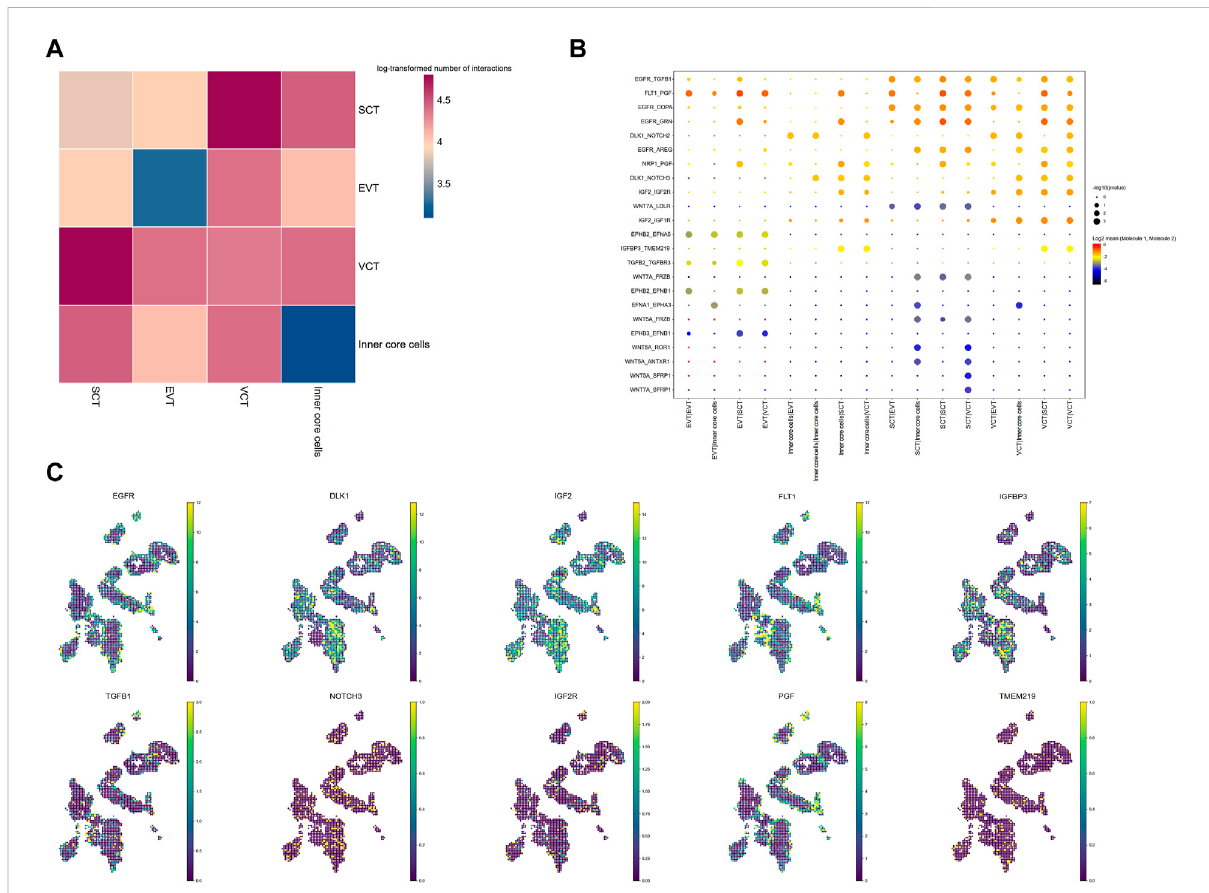
FIGURE 3 Intercellularinteractionsbetweendifferentcelltypesinplacentavilli. (A) Heatmapforthelog-transformednumberofligand-receptorpairsinall cell clusters. The different colors indicate log2 of the counts. (B) Interactions between selected ligand – receptor pairs; p values indicated by the size of circles. The means of the average expression level of the molecules in ligand-receptor pairs are indicated by color. (C) The distribution of representative ligand-receptor